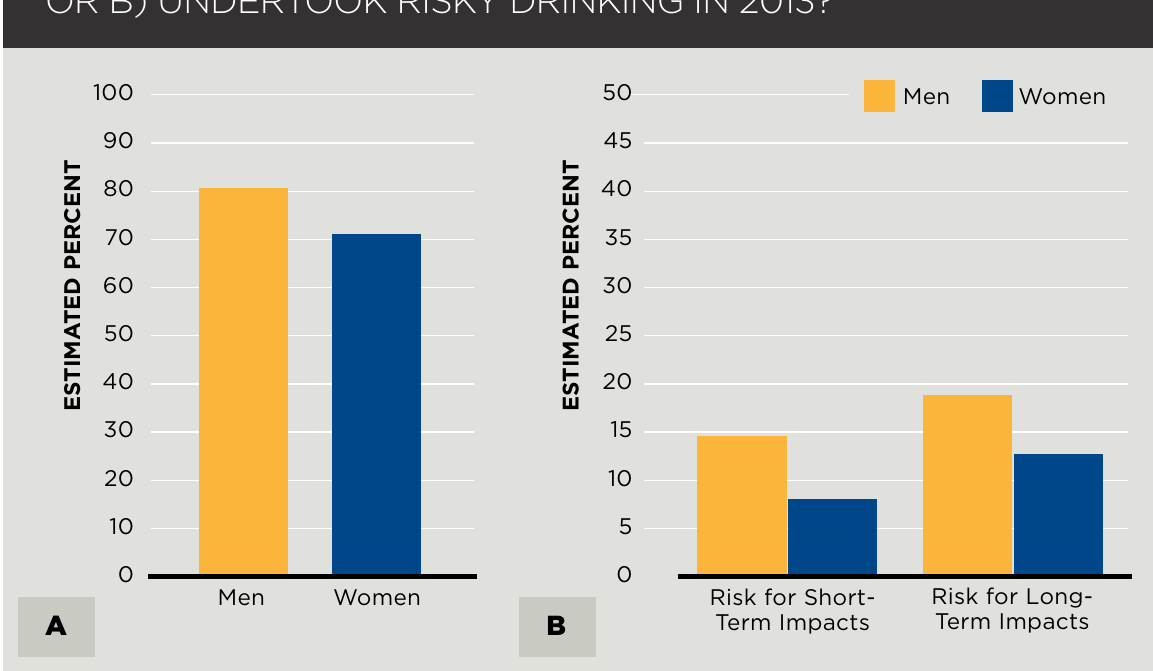
WHAT PERCENTAGE OF CANADIANS A) DRANK ALCOHOL OR B) UNDERTOOK RISKY DRINKING IN